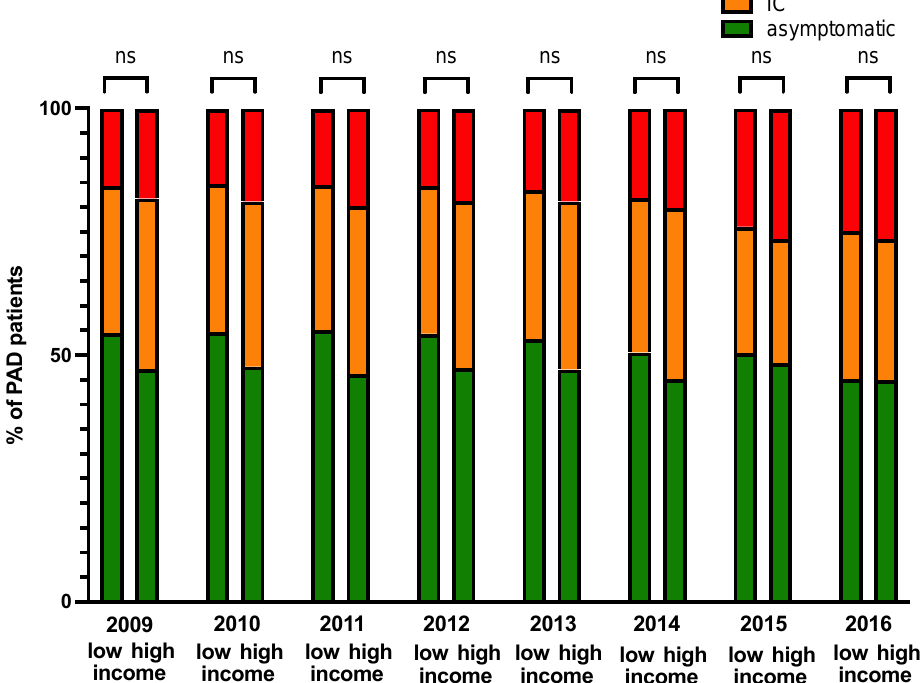
Figure 3. Peripheral artery disease stratified according to severity (asymptomatic, intermittent claudication (IC), critical limb-threatening ischemia (CLTI)). Severity of PAD did not differ between low-income and high-income areas (ns denotes not significant). High-income areas had higher outpatient vascular surgery and cardiology density during the study period, whereas the outpatient angiology density was higher in low- income areas (Figure 4).